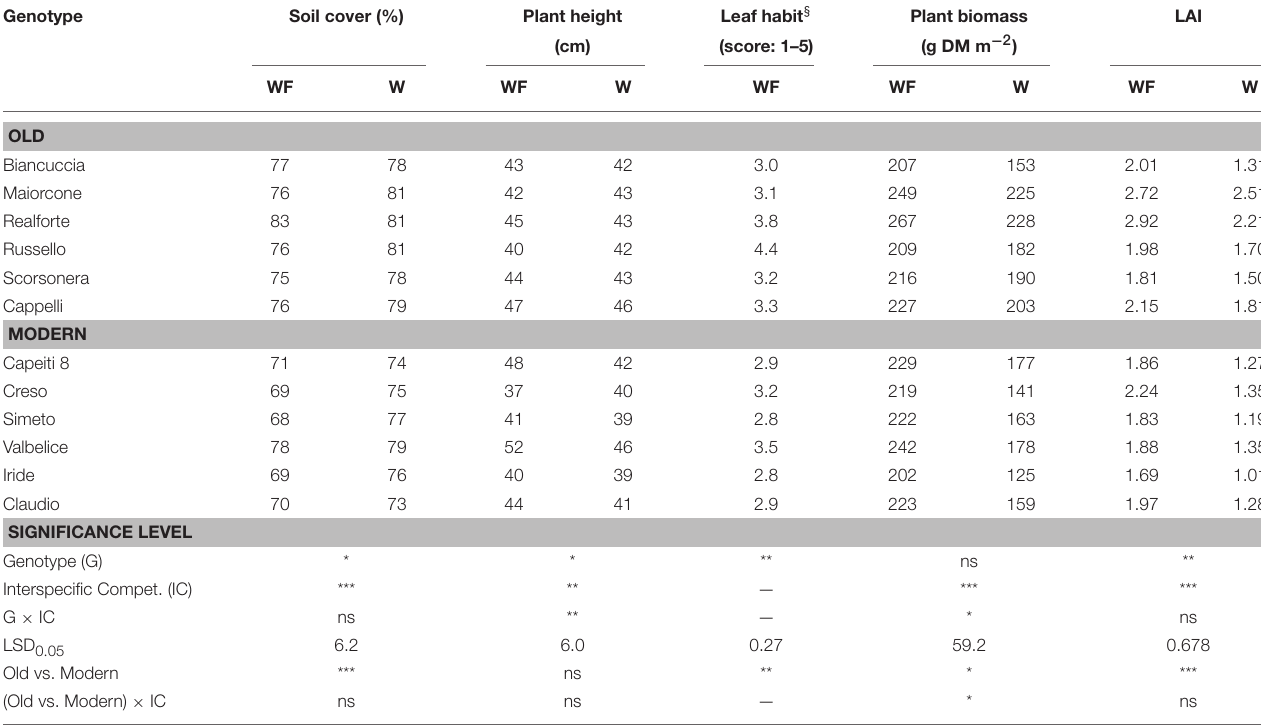
TABLE 2 | Wheat traits measured at the end of tillering in 12 genotypes grown in weed-free (WF) and weedy (W) conditions. Genotype Soil cover (%) Plant height Leaf habit